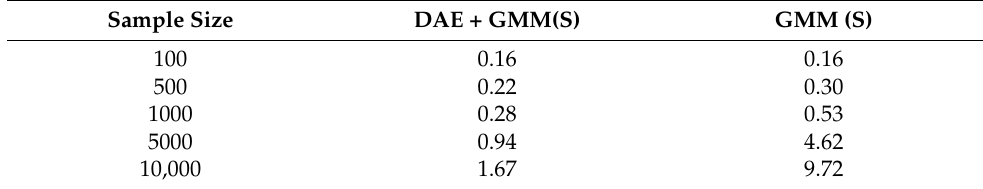
Table 3. Comparison of the clustering time of departure trajectories in the two